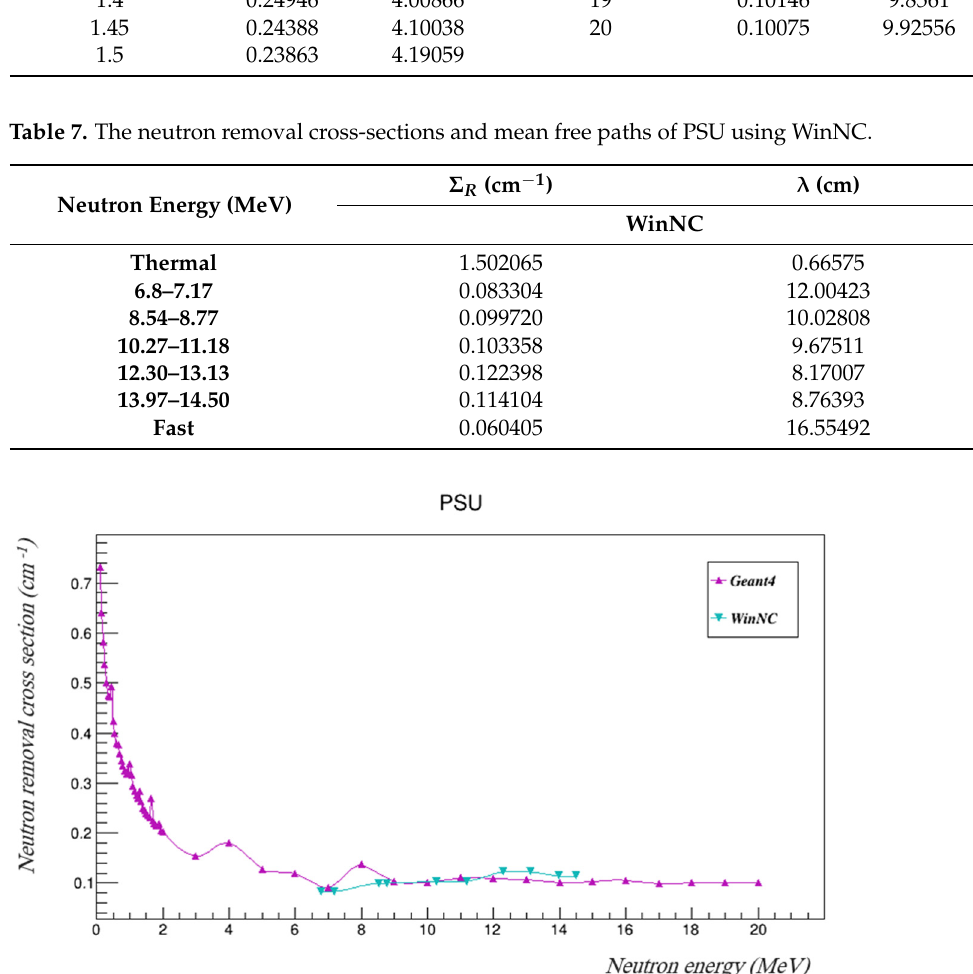
Figure 7. The neutron removal cross-sections of PSU at the investigated gamma energies using both Geant4 and WinNC.